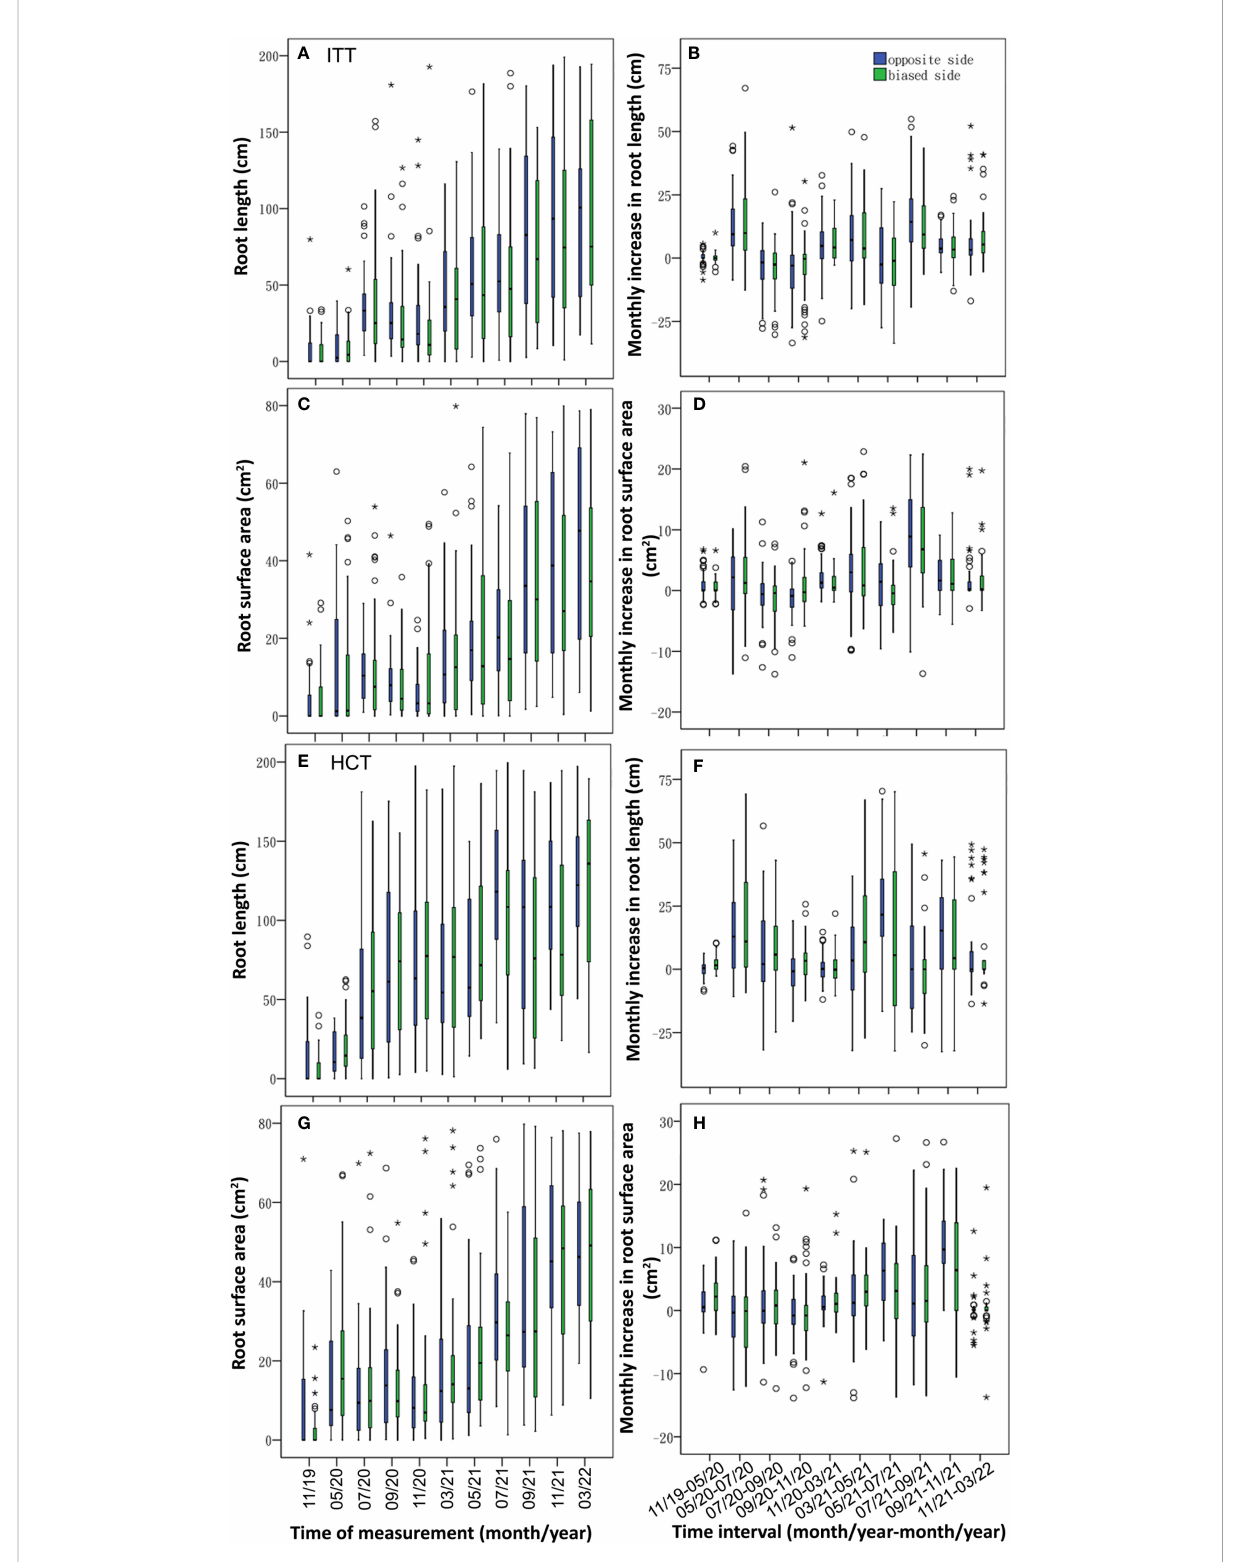
FIGURE 7 Temporal dynamics of root variables and their increment between 0 and 1 in ITT (A – D) and HCT (E – H)